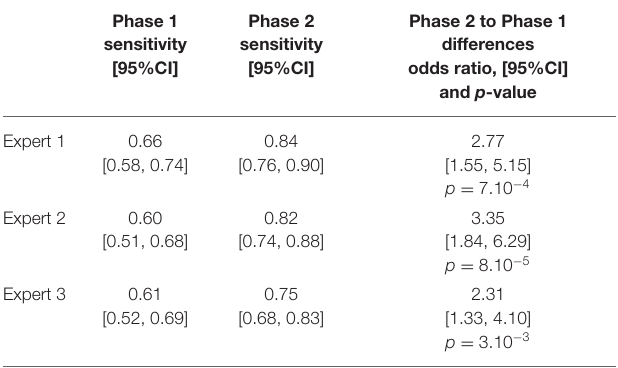
TABLE 6 | Ability of each expert to detect a new lesion during the two phases.